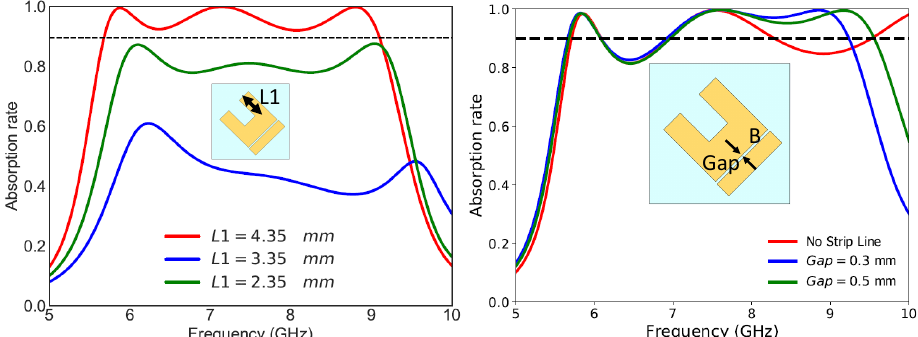
Figure 7. ( a ) Absorption rate for different values of L1, ( b ) Absorption rate for different values of the gap. An illumination of linearly polarized TE wave is considered.